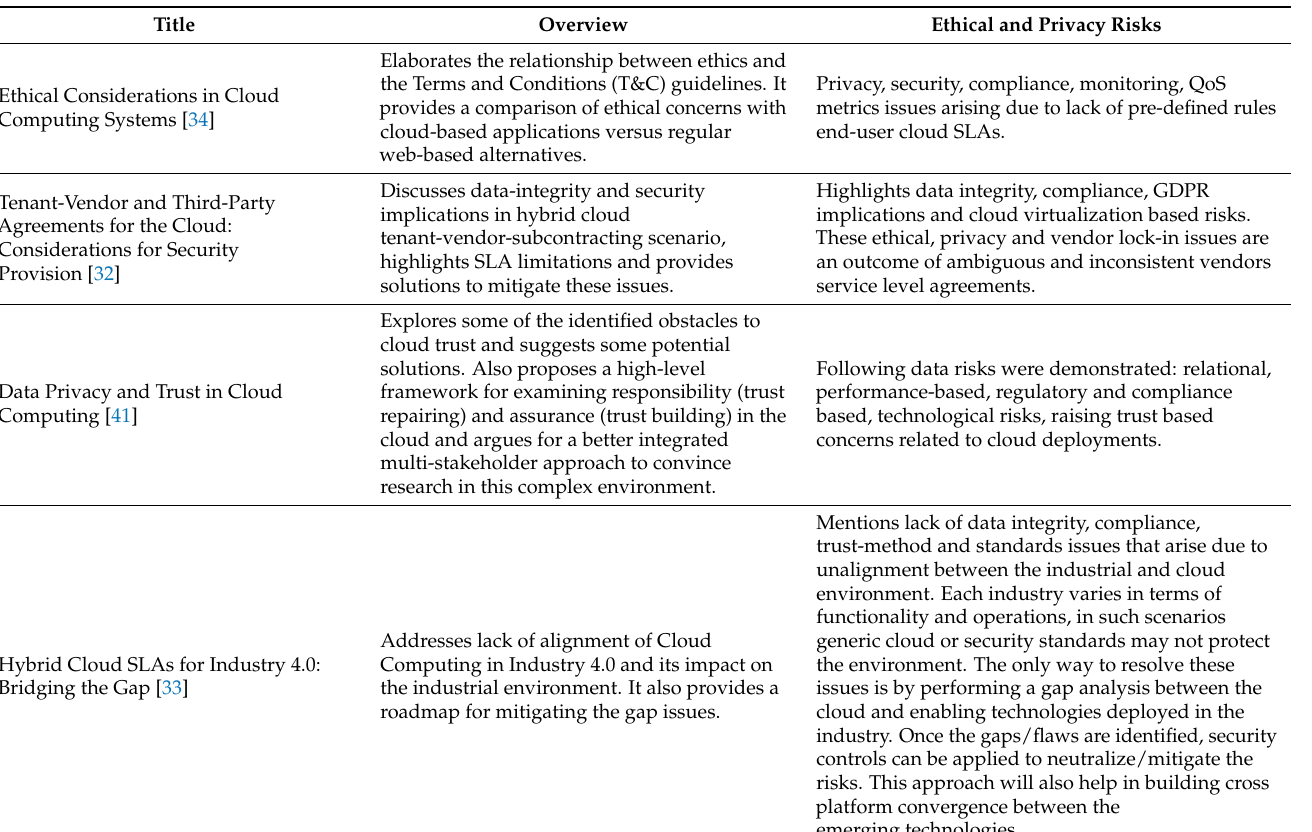
Figure 2. Some of the Cloud Federation challenges addressed by EU H-Cloud [39] (diagram adapted from [39] and redesigned in context of this research). Table 2. Ethics and privacy in Cloud